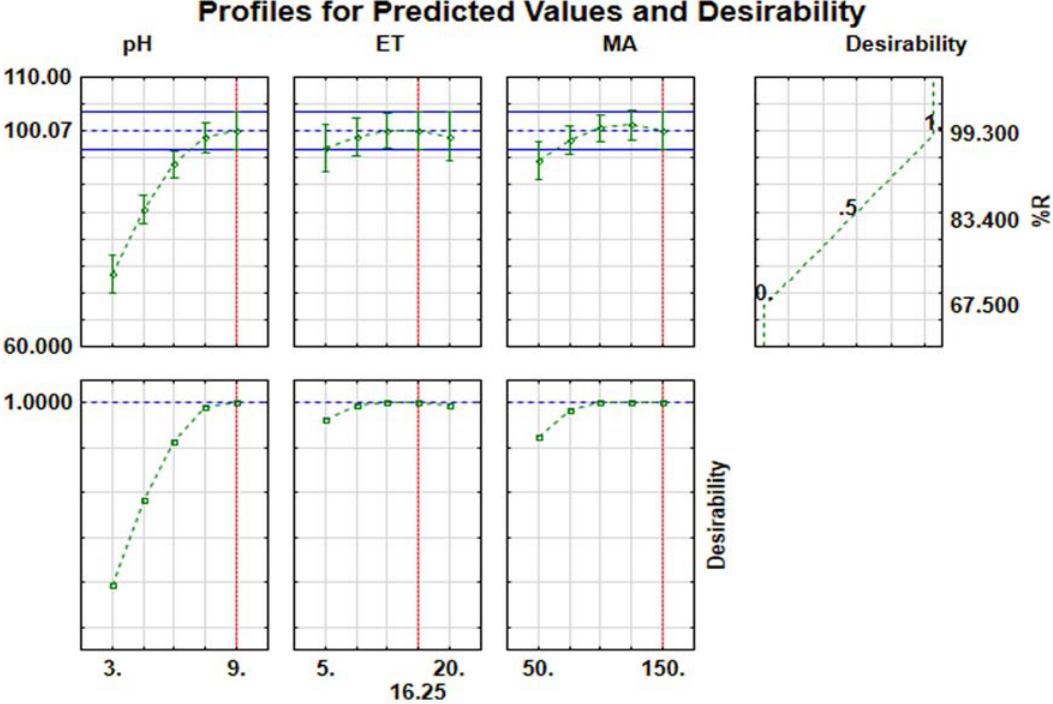
Figure 10: Pro fi le for the predicted values and DF for the removal percentages of Tl.